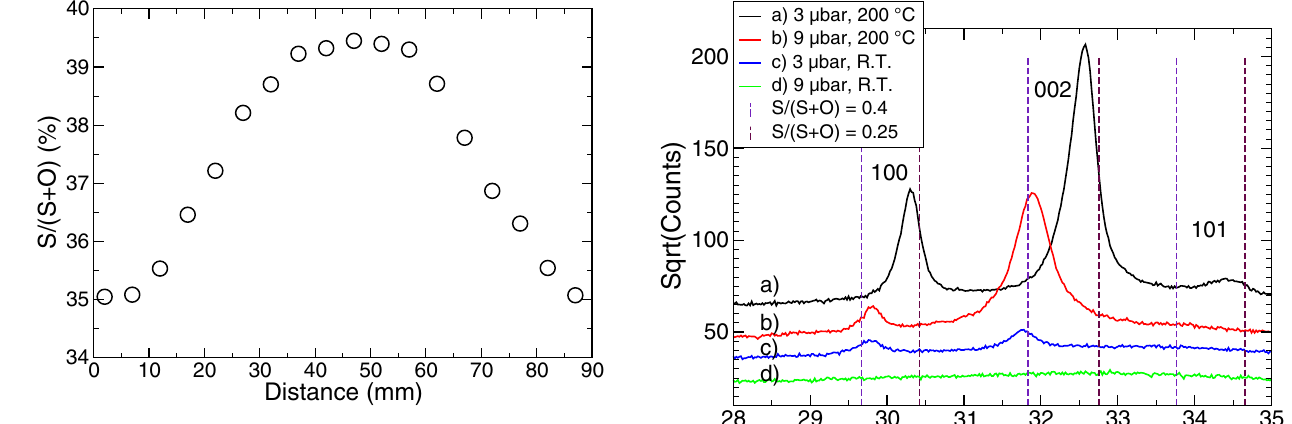
Fig. 2. S/(S +O) ratio across the substrate as measured by EDX. Table 1. Composition of Zn(O,S) films as measured by EDX.